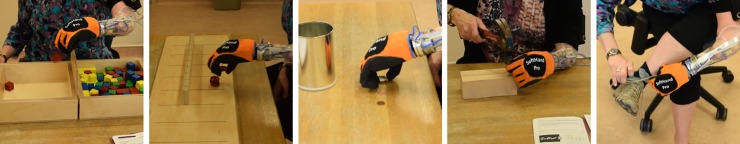
Clinical evaluation of prosthesis.Examples of participants completing the clinical measures. From left to right, Box and Blocks, the Jebsen Taylor Test of Hand Function (stacking checkers, moving small, common objects), and the AM-ULA (hammering a nail, shoe tying).